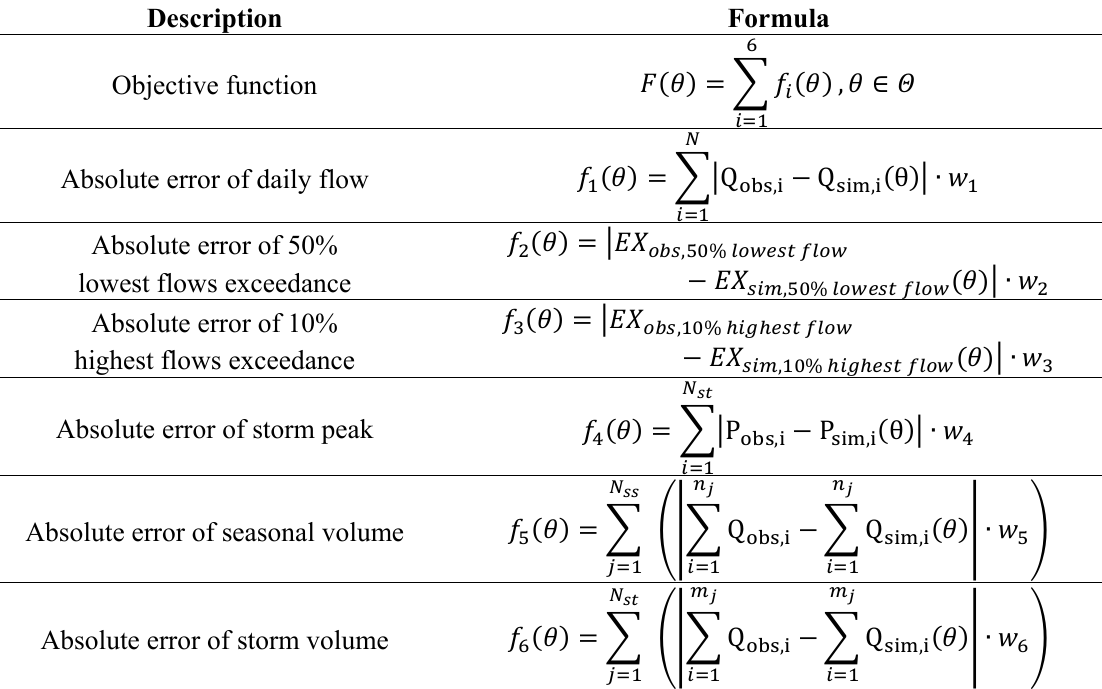
Table 2. Objective functions used in the HSPF-SCE tool (revised from Kim et al.